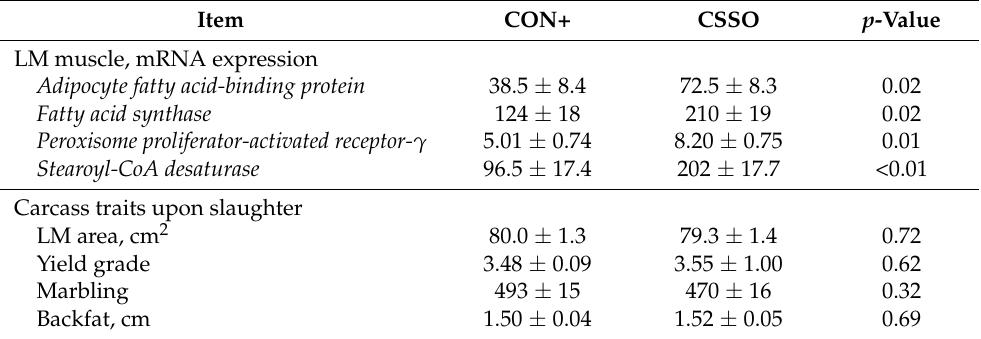
Table 5. Expression of mRNA (relative fold change) of longissimus muscle (LM) genes in the feedlot, and carcass traits of steers supplemented with Ca soaps of soybean oil (CSSO; n = 16) or prilled satu- rated fat (CON+; n = 16) from 2 to 4 months of age. Values reported are least square means ± standard error. Adapted from Schubach et al.